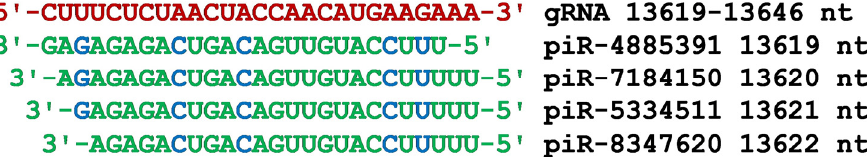
Figure 8. Nucleotide sequences of the four piRNA BSs cluster in the region of gRNA from 13,919 nt to 13,646 nt and the nucleotide sequences of piRNAs. Note: The piRNA nucleotides that form canonical pairs with gRNA are highlighted in green and non-canonical pairs are highlighted in blue. The names of the piRNAs are followed by the beginning of their